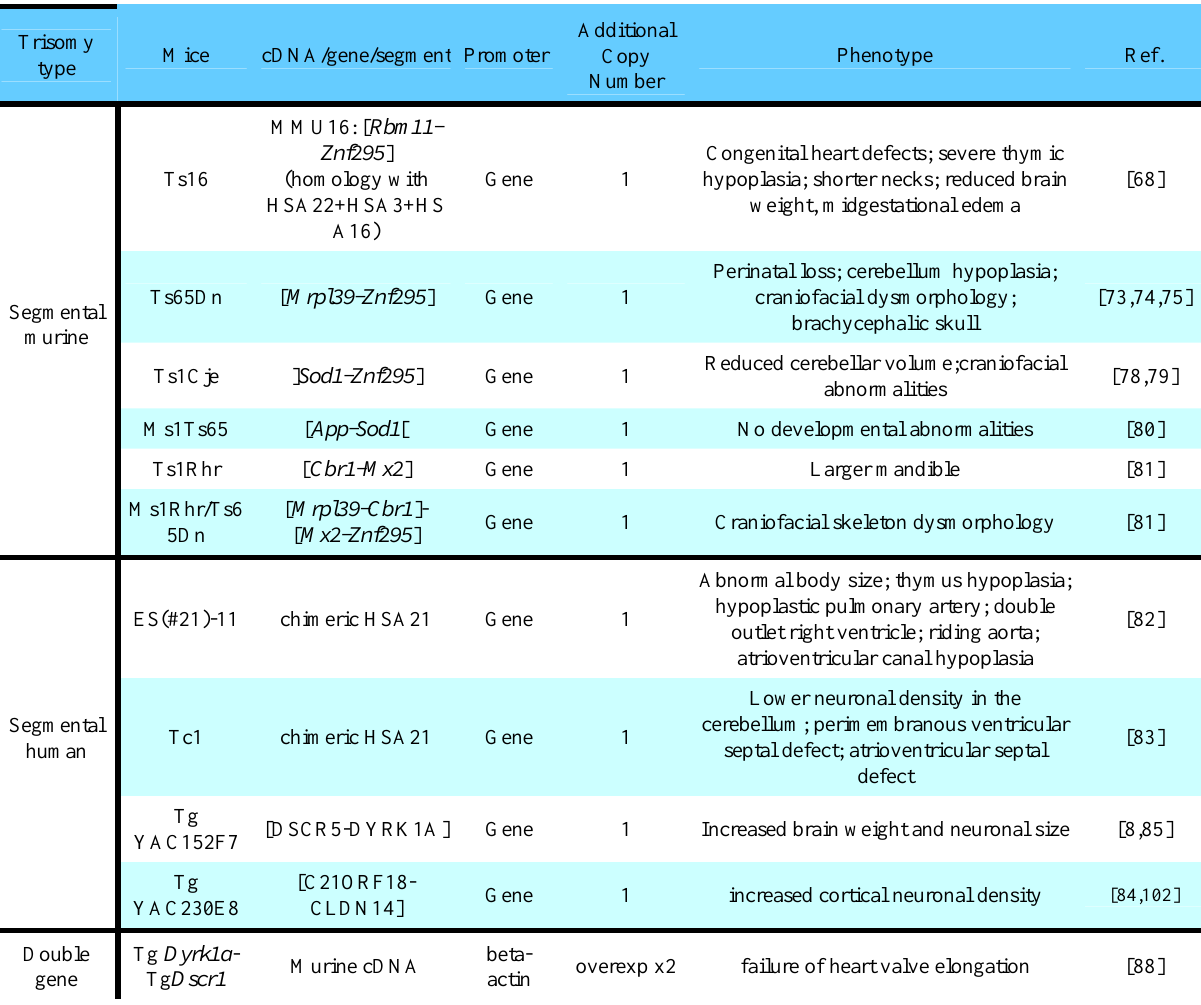
Developmental Defects in Murine Models of